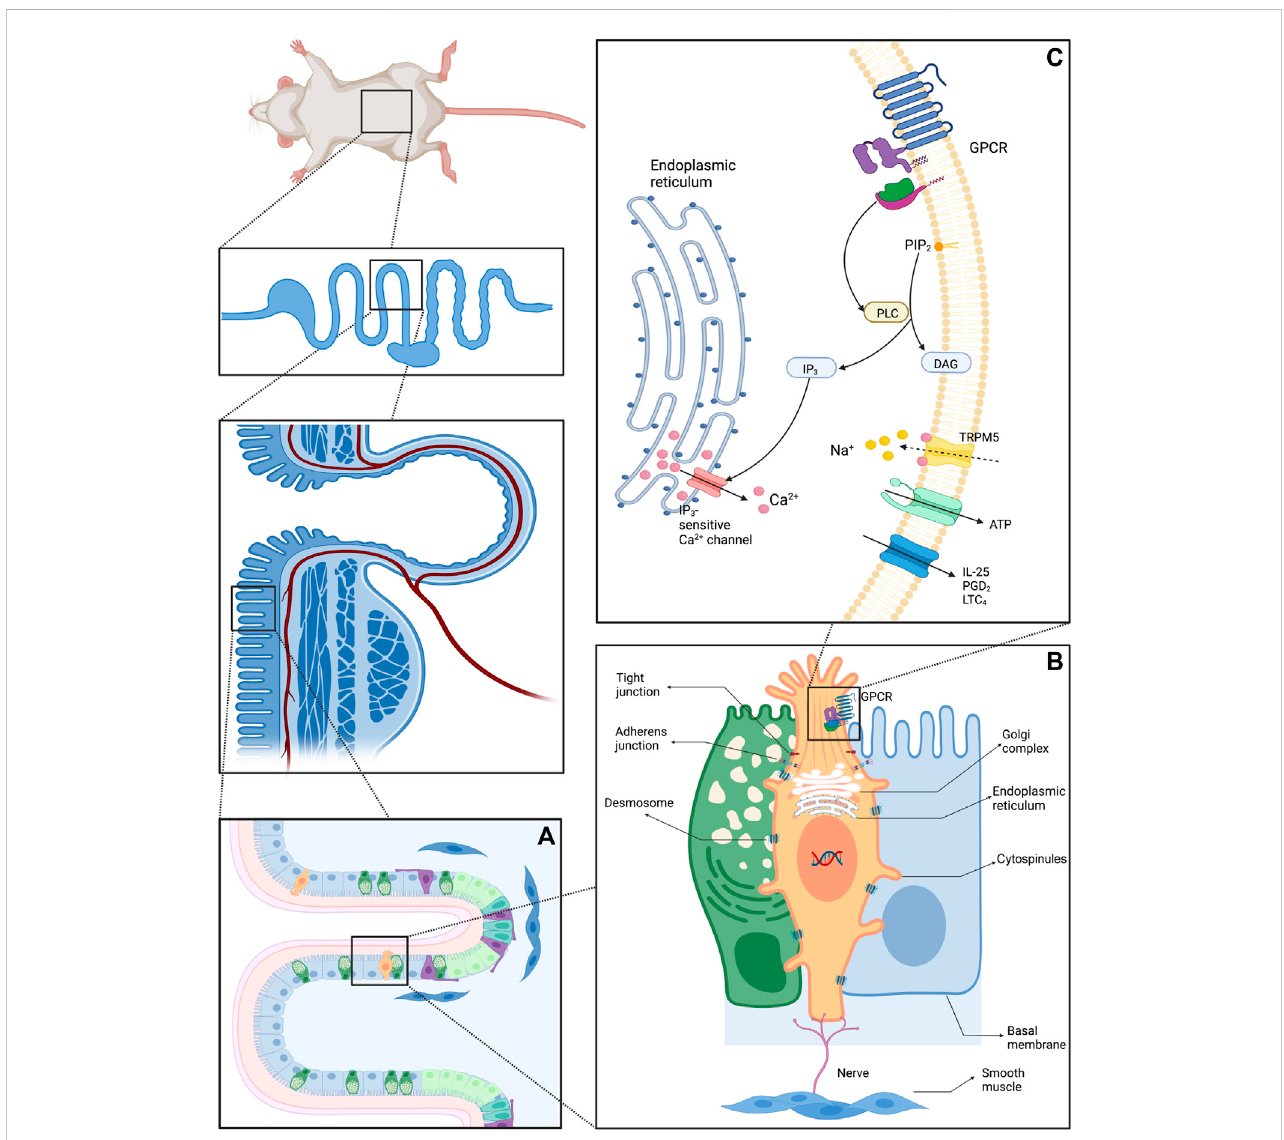
FIGURE 1 Diagram of the structure and composition patterns of IECs (A) Schematic diagram of Lgr5 + stem cells and differentiated progeny of the crypt-villus (B) StructureofintestinalTCsandadjacententerocytes:IntestinalTCspossessdistinguishmorphologicalcharacteristics,especiallytheuniquebrushborder.The cytospinules can directly contact the neighboring cells, serving as a bridge between the extracellular and intracellular environment. The tubular network within TCs can transport cargo via vesicles. (C) Schematic diagram of the vicinity of the TC cell